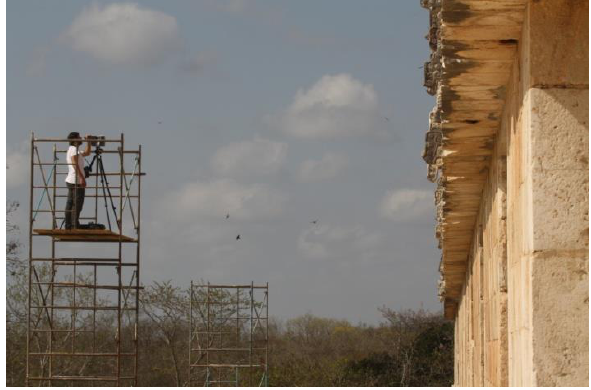
Figure 12. Laser scanner data capture from the scaffolding tower. (Photo G. Muñoz